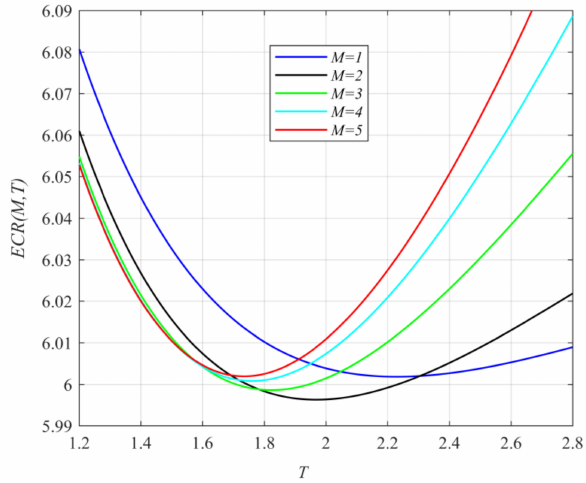
Figure 4. The effectiveness validation of RHPR.